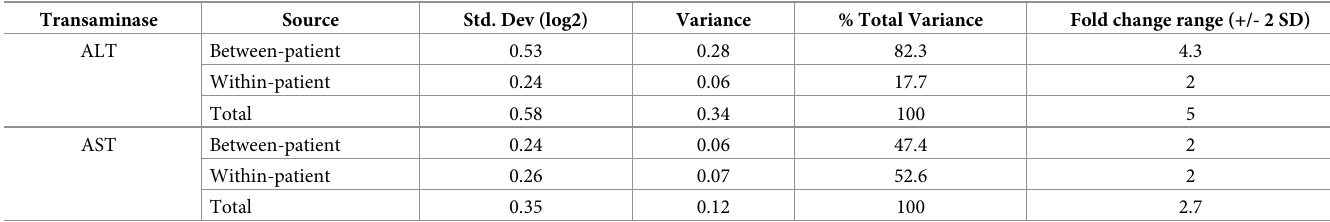
Table 4. Variance component analysis of alanine transaminase (ALT) and aspartate transaminase (AST) in serum from healthy